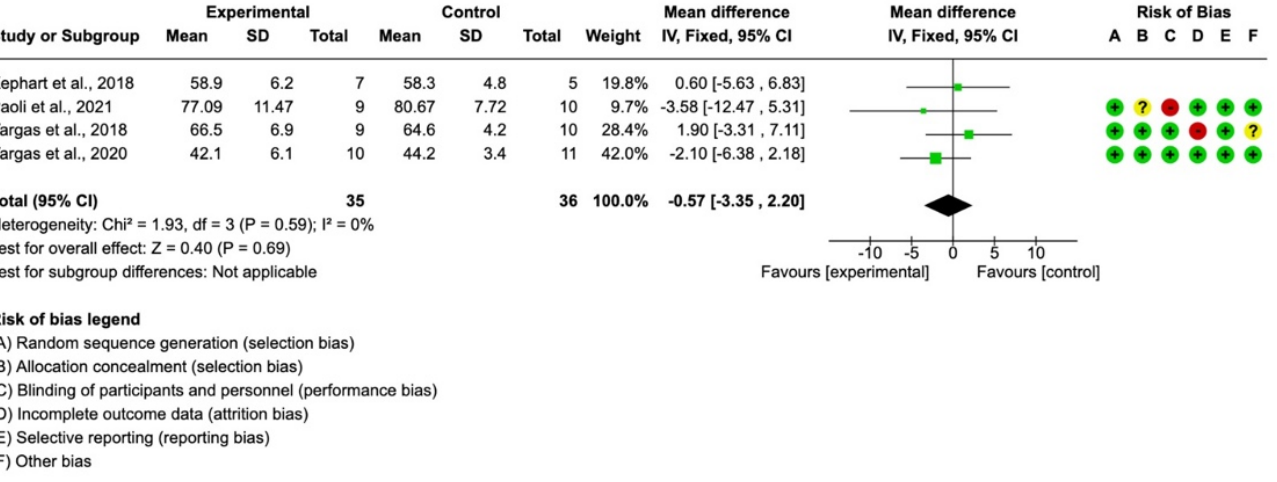
Figure 3. Forest plot for fat-free mass.